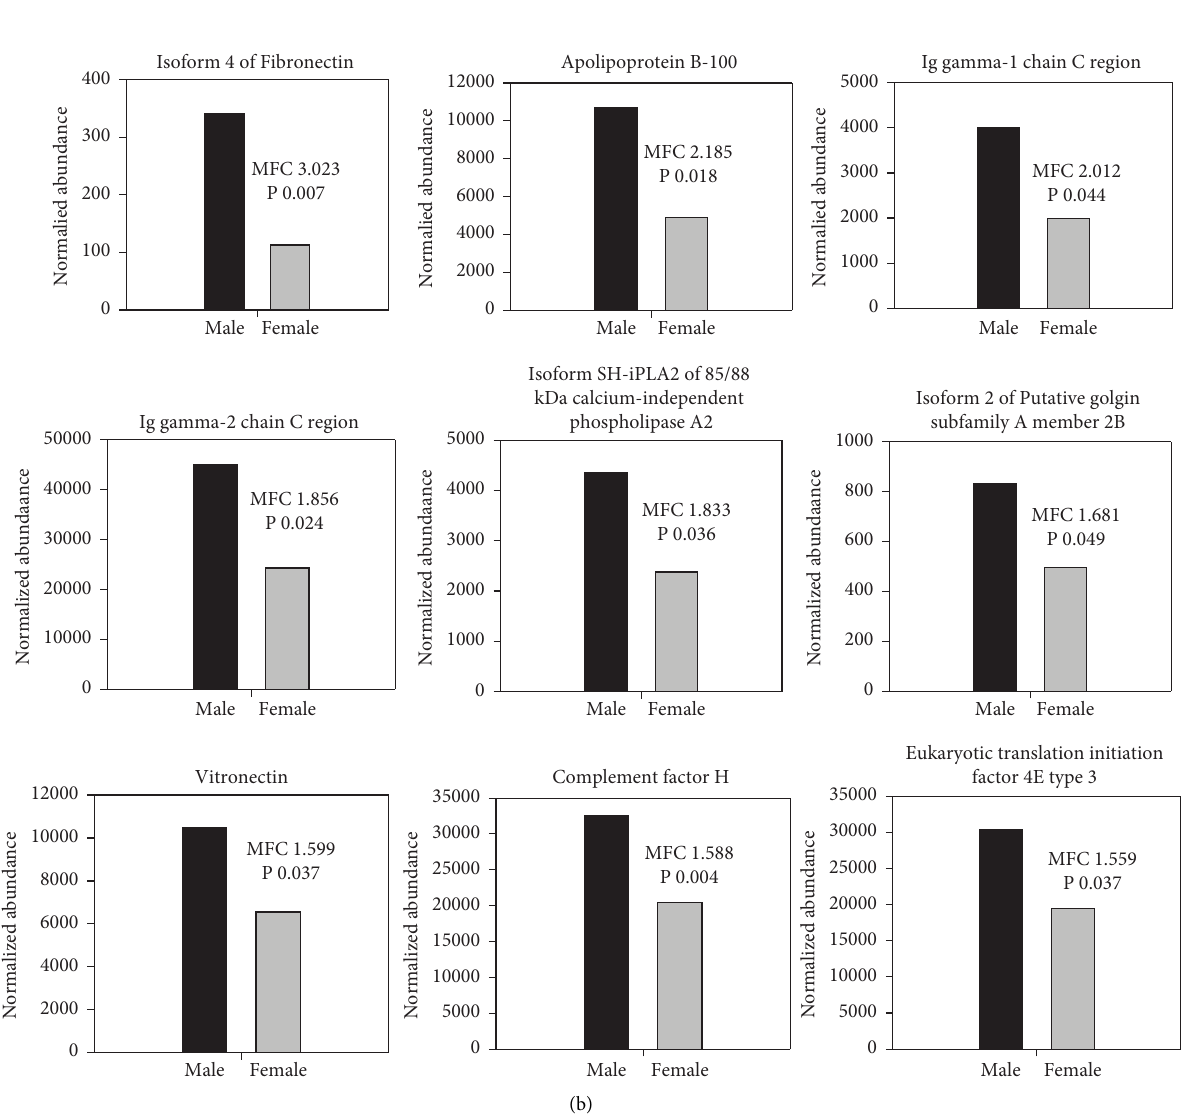
Figure 1: Histograms of the normalized abundance of diferentially expressed proteins/peptides (PPs) identifed in healthy males (black) and females (grey). (a) PPs upregulated in women compared with men, and (b) PPs upregulated in men compared with women. Te P -values (ANOVA) and magnitude of change (maximum fold change–MFC) are indicated for each PP in each fgure. Te proteins were identifed using label-free quantifed liquid chromatography-tandem mass spectrometry on Synapt G2 analysis–LC-MS/MS. Progenesis QI for proteomics software was used for data analysis. Note . Tere are no bar errors as samples are usually pooled in LC-MS/MS